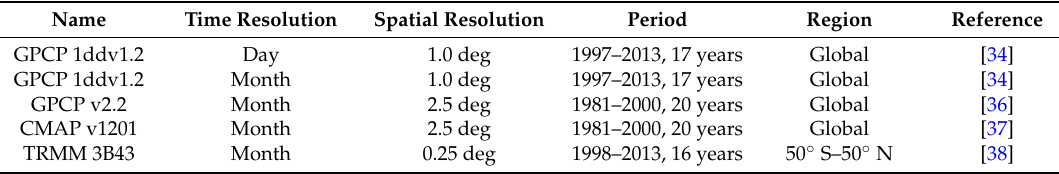
Table 2. Observational data of precipitation used in this study. GPCP: Global Precipitation Climatology Project. 1dd: the One-Degree Daily data. CMAP: Climate Prediction Center Merged Analysis of Precipitation, TRMM: the Tropical Rainfall Measuring